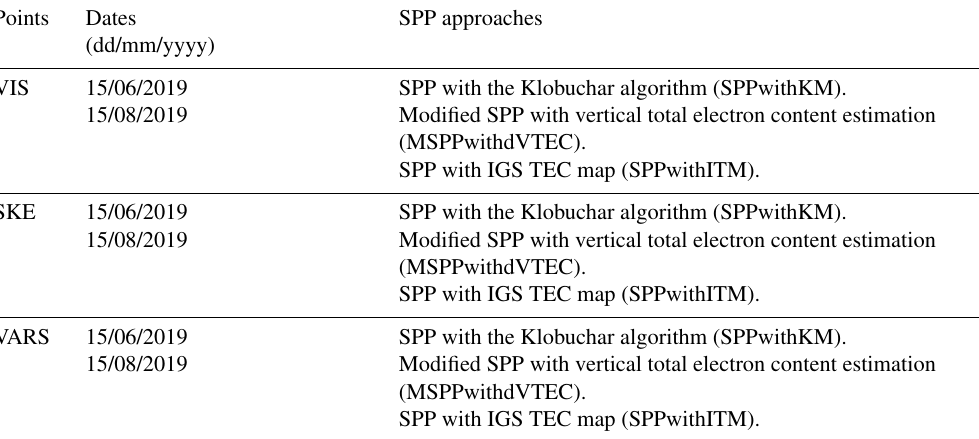
Table 2. Experiment